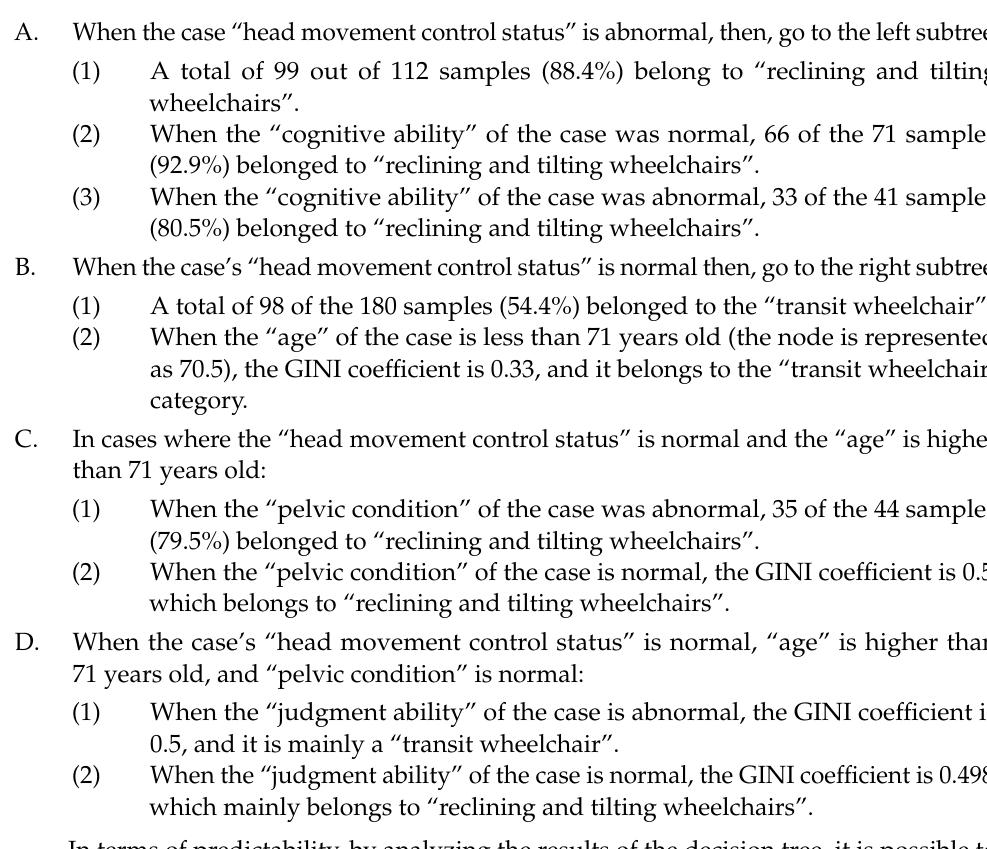
Figure 3. Decision tree path diagram. Note: 1. Samples represent the number of cases of this node; value represents the number of “reclining and tilting wheelchair” samples, and the number of “transit wheelchair” samples*1.4 (sample weight); class represents the classification result of this node. 2. RTW = reclining and tilting wheelchair, TW = transit wheelchair.